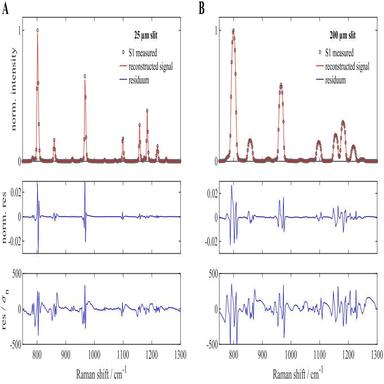
Example of spectral reconstruction of normalized atomic emission spectra (top), the corresponding residuum (center) and the noise-weighted residuum (bottom) for Setup S1 using a neon calibration lamp; A) for a 25 μm slit with unrestricted peak parameters, B) for a 200 μm slit using the fitted core Voigt parameters of S1. The figure only shows a cropped section of the whole spectrum.